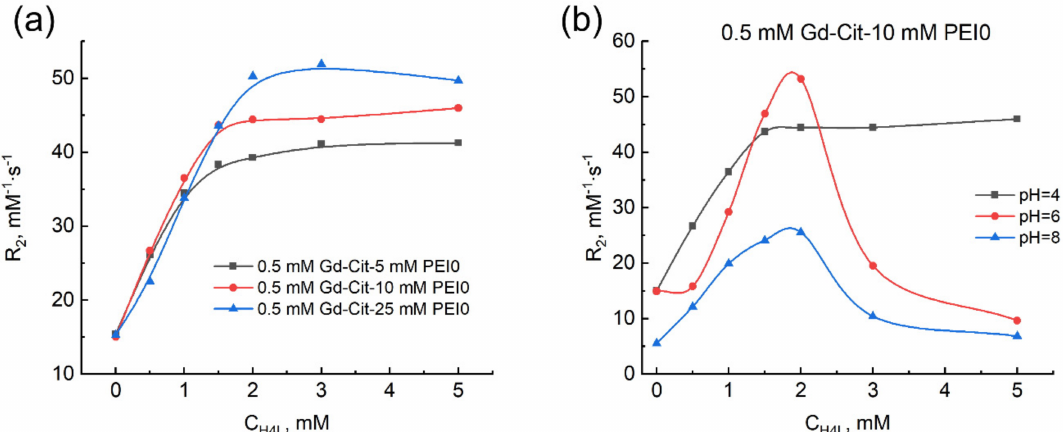
Figure 4. Dependence of the relaxation effectiveness in the gadolinium(III)–citric acid–PEI0 system on the concentration of ligand, C H4L . C Gd(III) = 0.5 mM, C PEI = 5.0 mM ( a ), 10 mM ( a , b ), and 25 mM ( a ). pH 4 ( a , b ), pH 6 ( b ), pH 8 ( b ).